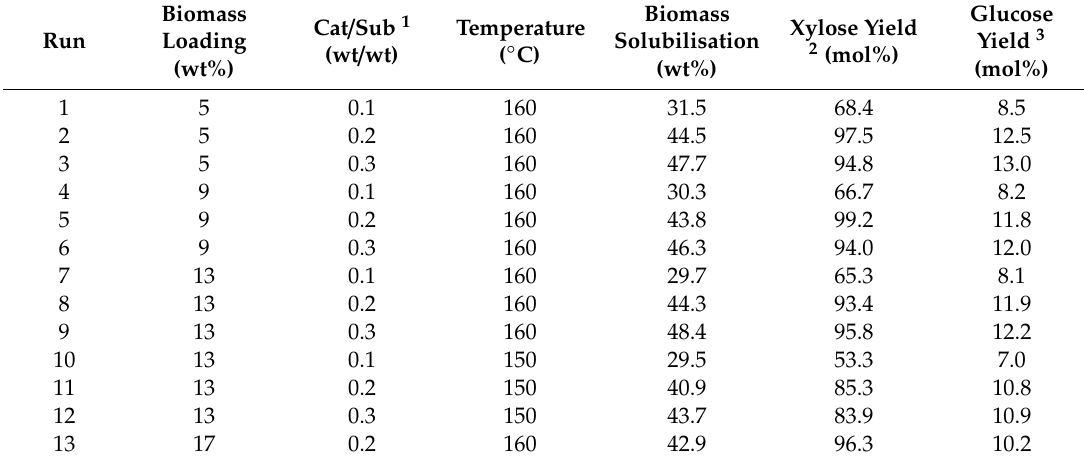
Table 3. Experimental set-up and results of hemicellulose hydrolysis. Reaction conditions: MW heating, 20